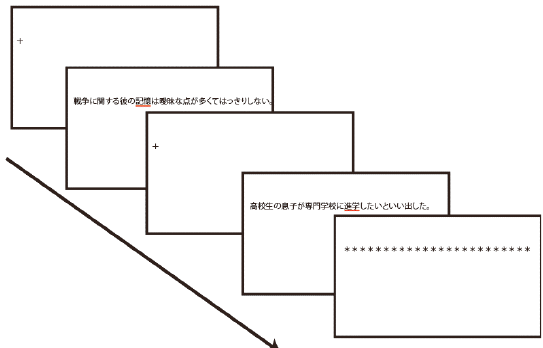
Figure 1 . Example of presentation sequence for the two- sentence task. (English translation of the first sentence; Much of his memory regarding the war is mostly unclear, and its target word is memory , the second sentence; My son is high school student and claims to go on to technical college, and its target word is shingaku , a noun that means to go to a higher school) Participants are instructed to remember the underlined word under the RST condition but are not required to remember the word under the READ